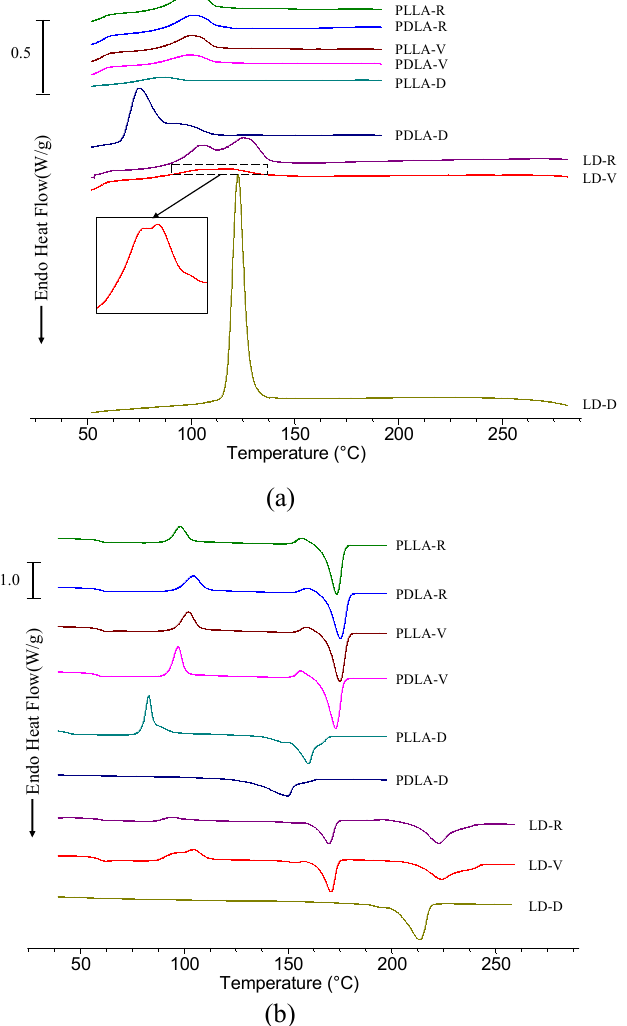
Figure 7. DSC ( a ) cooling curves and ( b ) reheating curves for PLLA, PDLA, and LD at a heating rate of 10 °C/min.